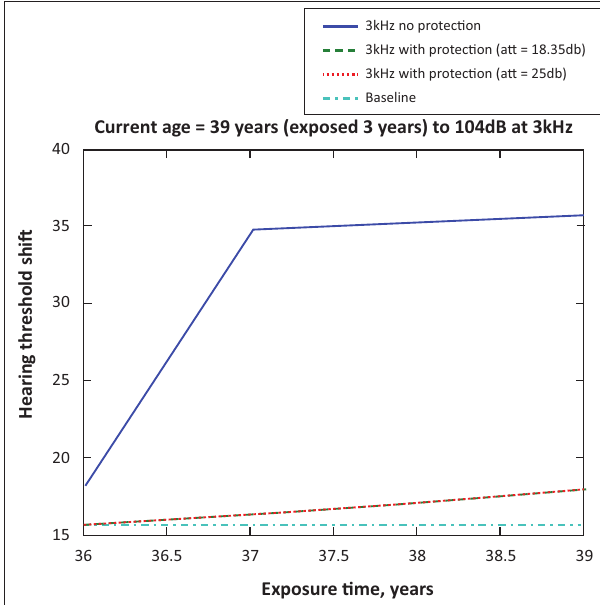
Source : Figure created using data from Moroe, N.F. (2018). Occupational noise-induced hearing loss in South African large scale mines: From policy formulation to implementation and monitoring . Doctoral thesis. Johannesburg: University of the Witwatersrand. FIGURE 5: Thirty-nine years old at 3000 Hz with exposure levels of 108 dB.